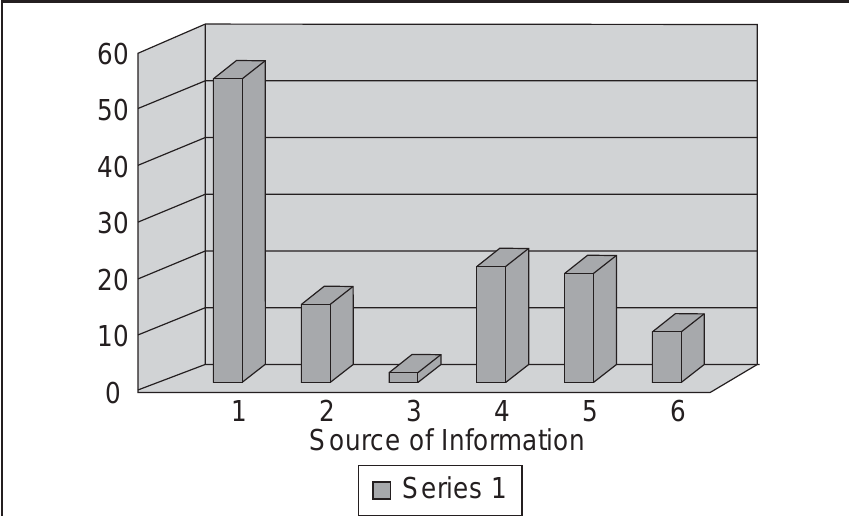
Figure 1: Sources of information of the participants about back education.